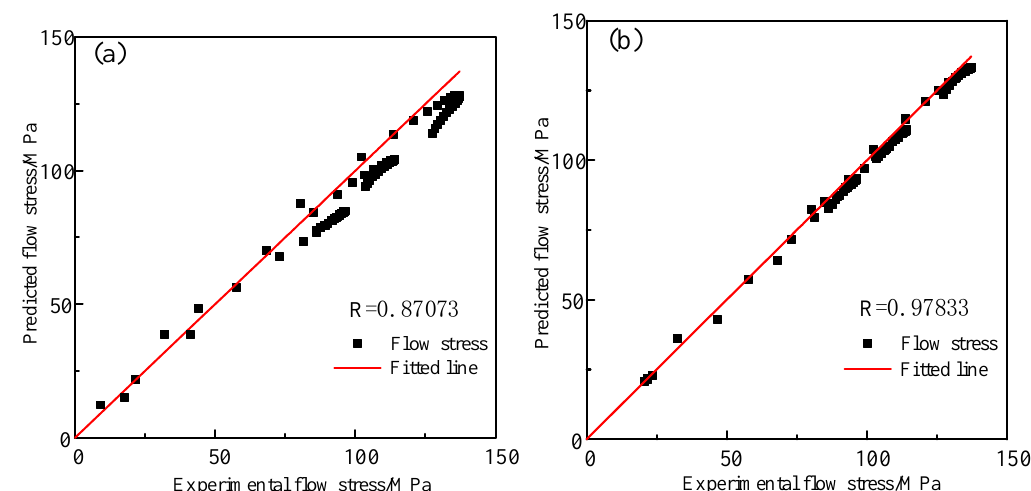
Figure 11. Optimization curve of objective function. Table 2. Hansel–Spittel model parameters identified by reverse optimization.